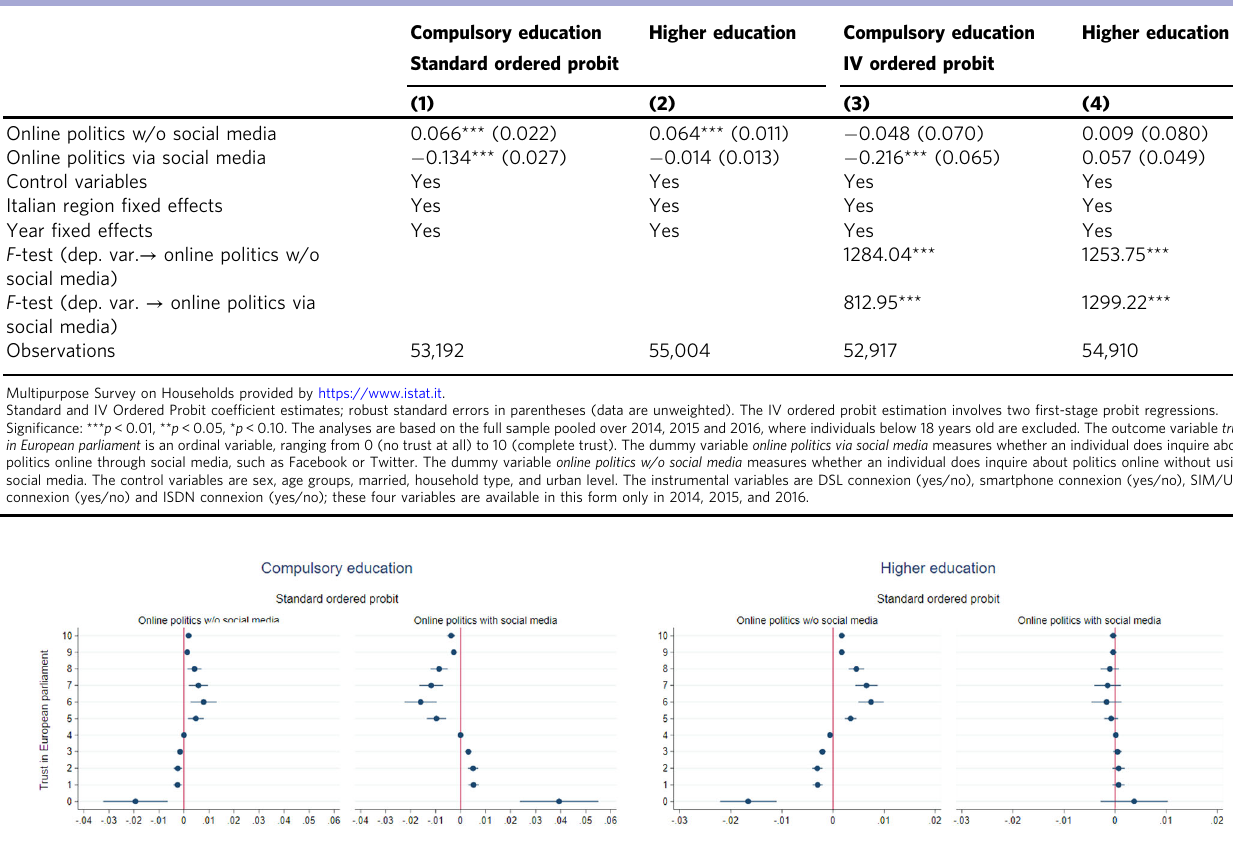
Table 4 Standard and IV Ordered Probit regressions of trust in European parliament on online politics by education.